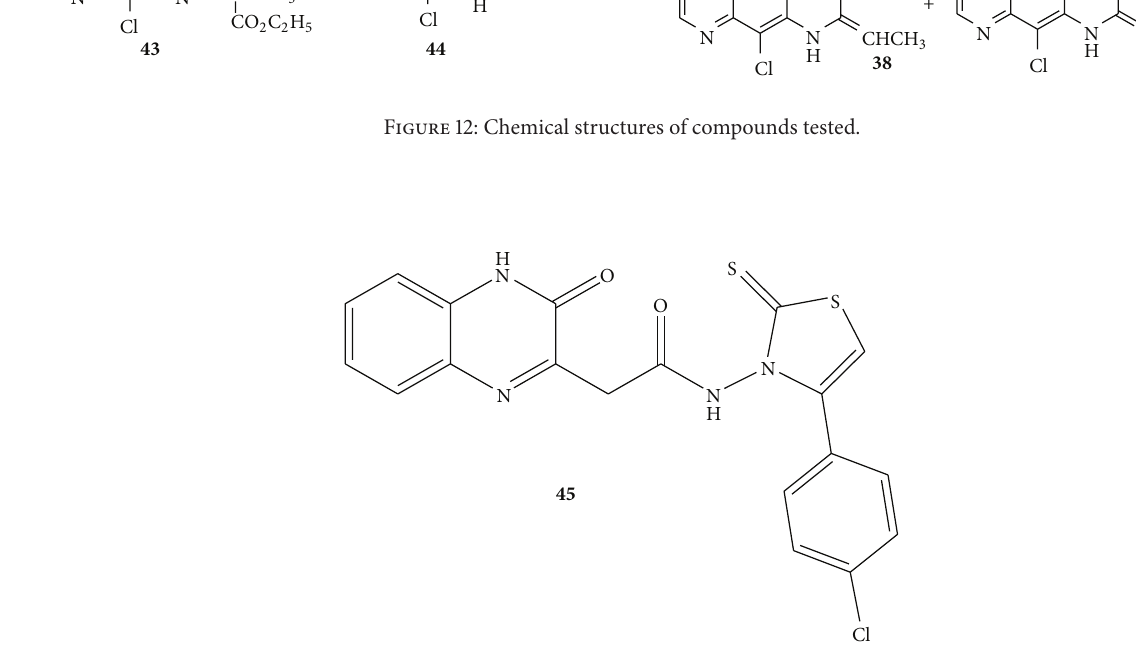
Figure 13: Chemical structures of compound 45